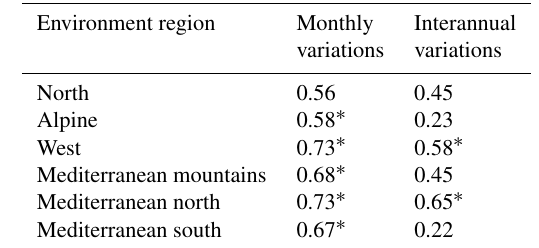
Table 4. Spearman rank correlations between large wildfires ( > 100ha) observed and that expected from simulated probabilities at the monthly (second column) and interannual (third column) timescales. The symbol ∗ indicates significant correlation at the 95% confidence